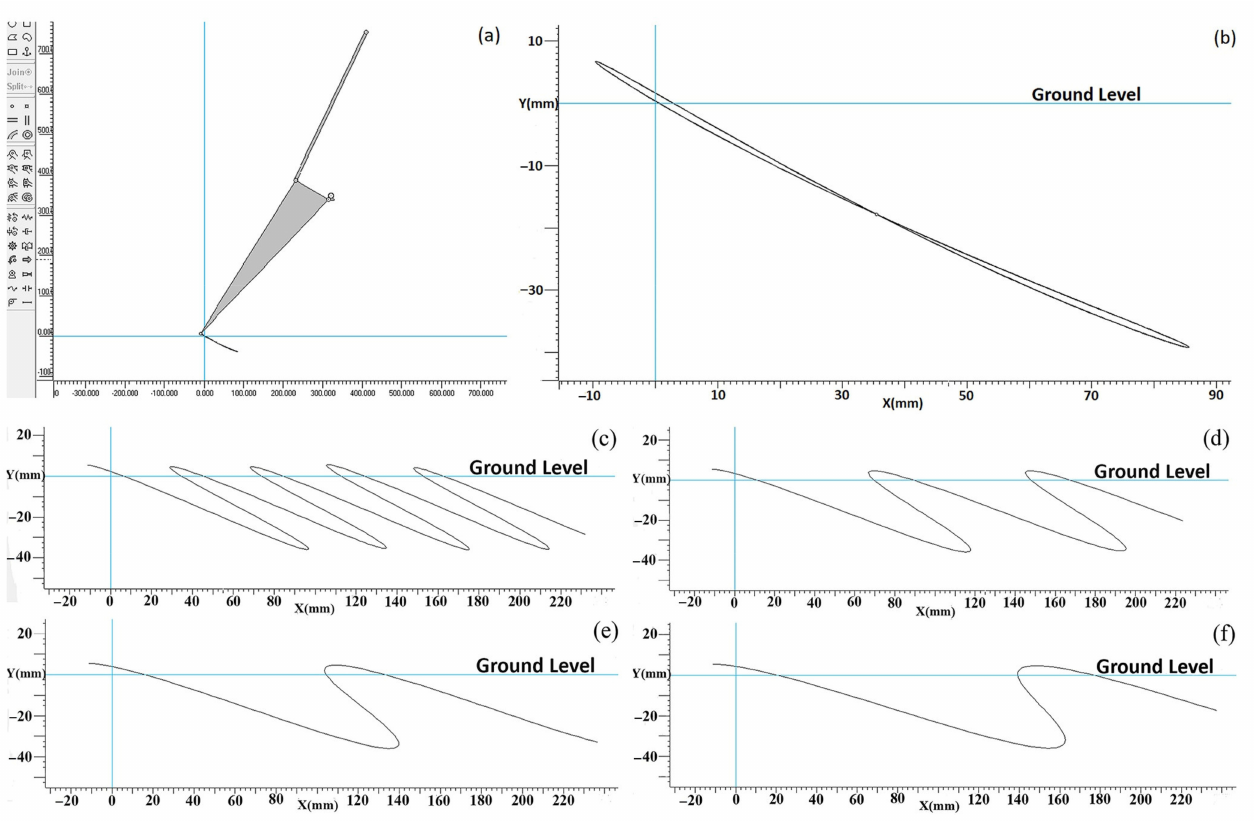
Figure 13. QNM-based synthesized mechanism in Working Model 2D software: ( a ) simulated mechanism, ( b ) the side view of the tracked path in the static state of the mechanism, ( c – f ) the side view of the tracked paths in the dynamic states of the mechanism at different travel speeds, respectively, are 2 km h − 1 , 4 km h − 1 , 6 km h − 1 , 8 km h − 1